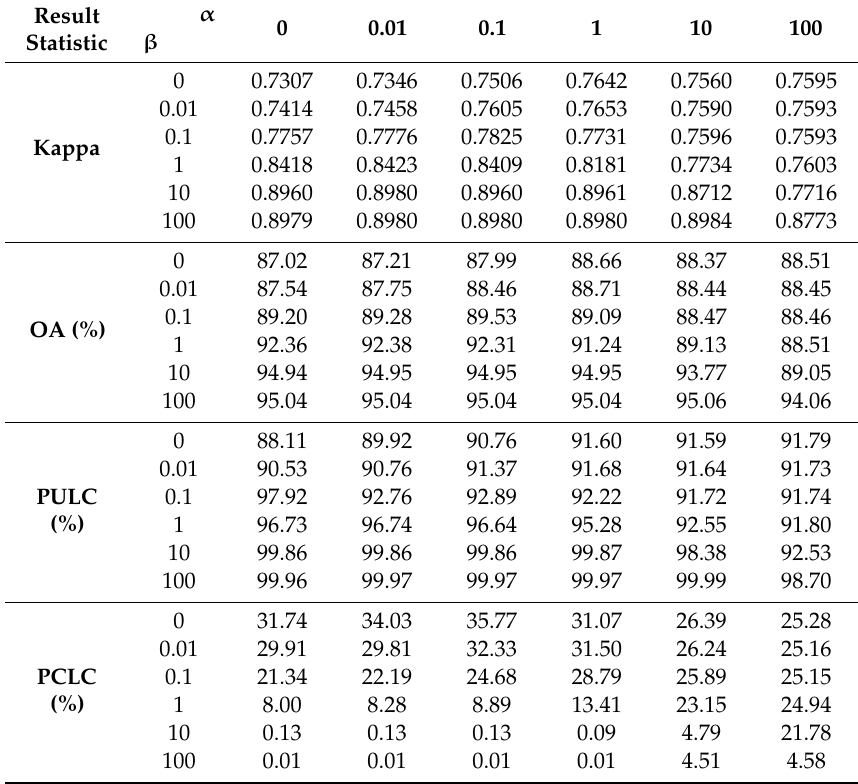
Table 5. Accuracy statistics of the MSST_SRM method with di ff erent weighting coe ffi cients ( δ =